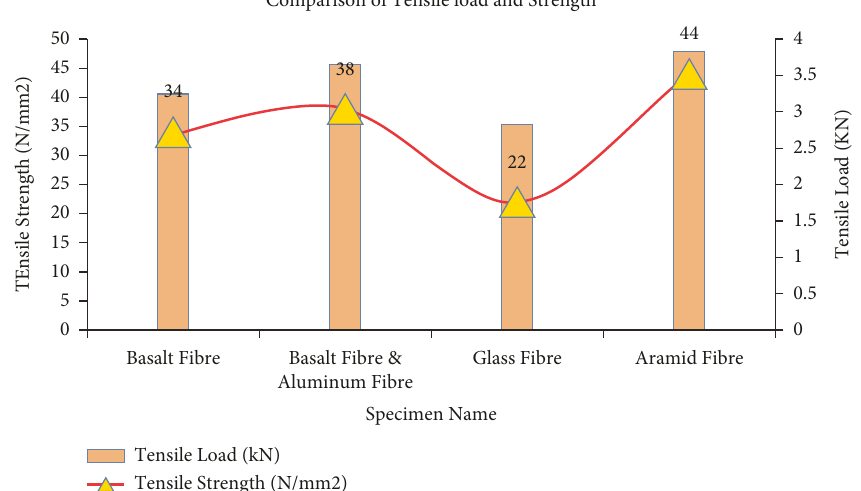
Figure 10: Comparison of tensile strength for different tensile loads.